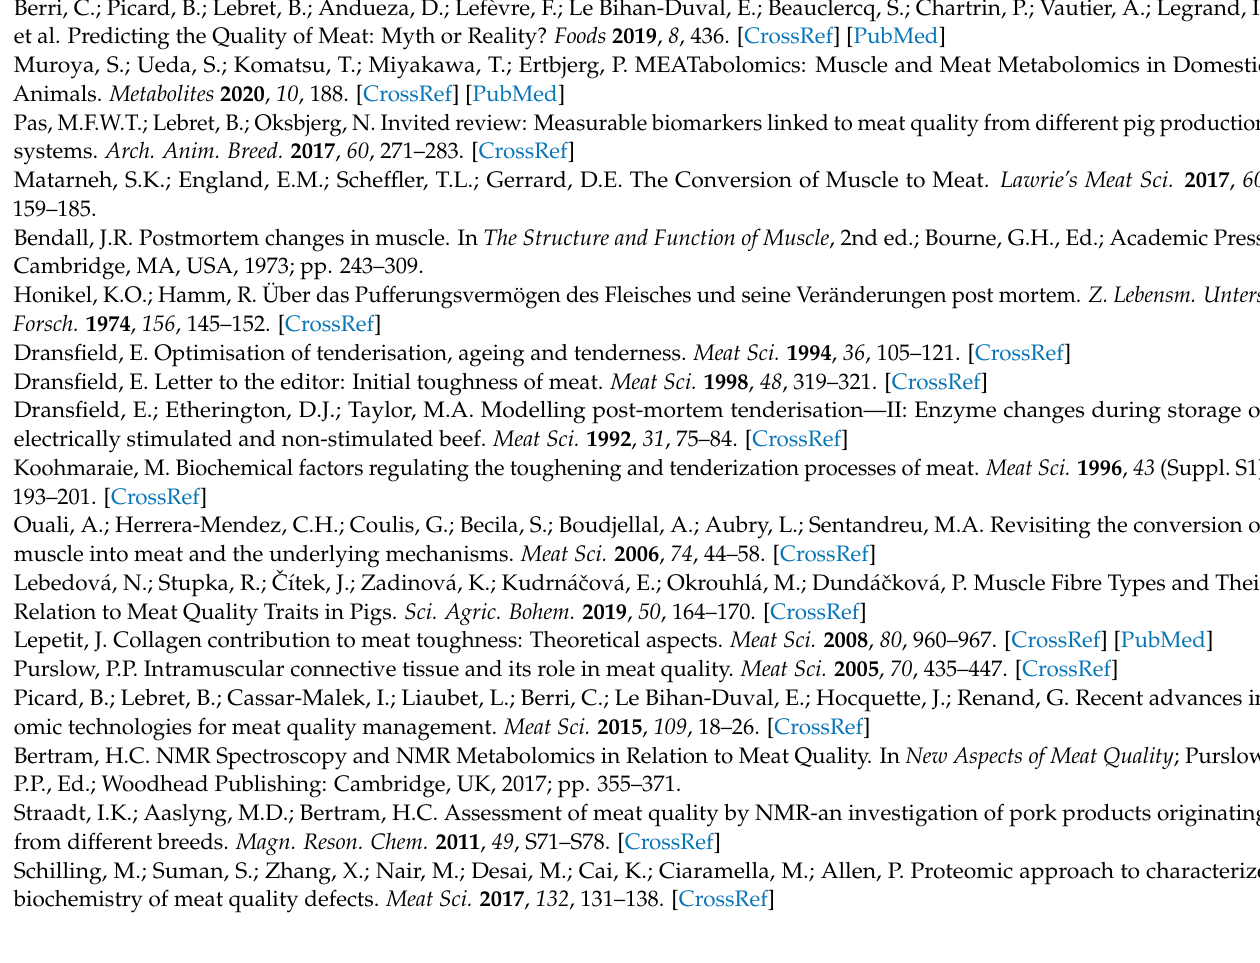
Table S2: Overview of molecular features as obtained by univariate statistical testing and OPLS-DA analysis; Supplementary Table S3: Chemicals and measurement parameters for GC × GC qMS analysis. Supplementary Table S4: Composition of the feeding diet. Supplementary Table S5: GC × GX qMS preprocessed data used for statistical